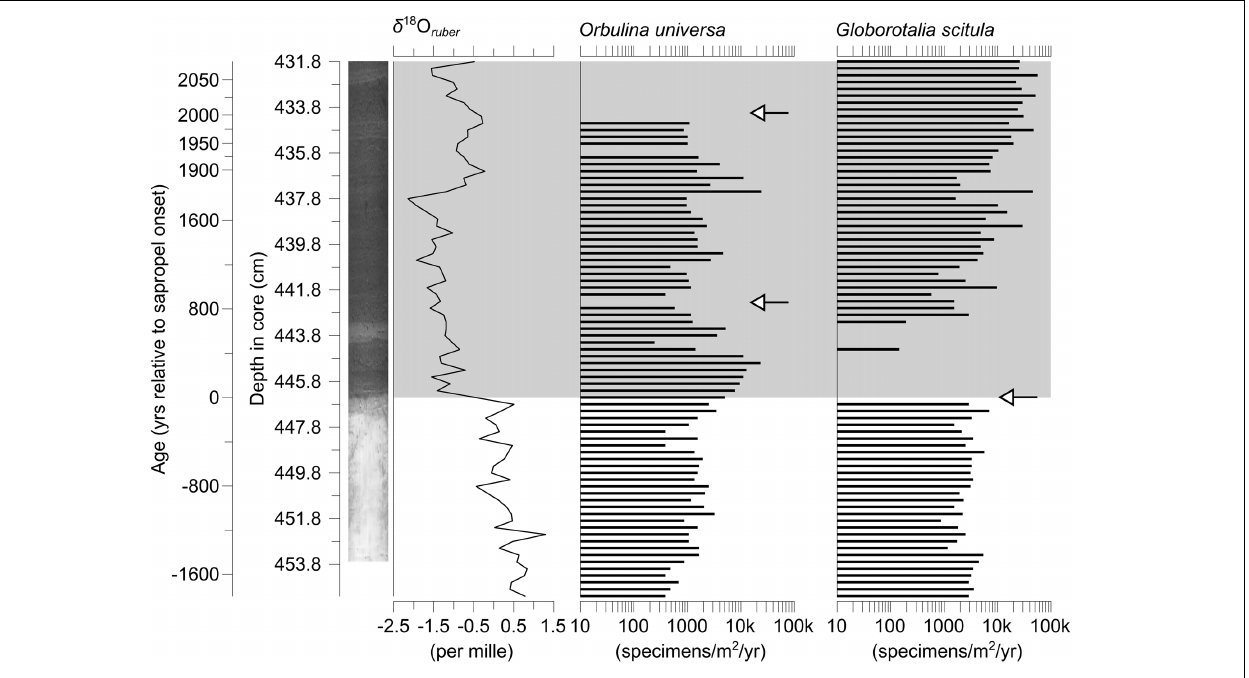
FIGURE 3 | Accumulation rates of shells of the two species of planktonic Foraminifera in core M51-3/SL104 investigated in this study. The δ 18 O values of shells of Globigerinoides ruber (white) from the same core serve as a geochemical marker for freshwater injection